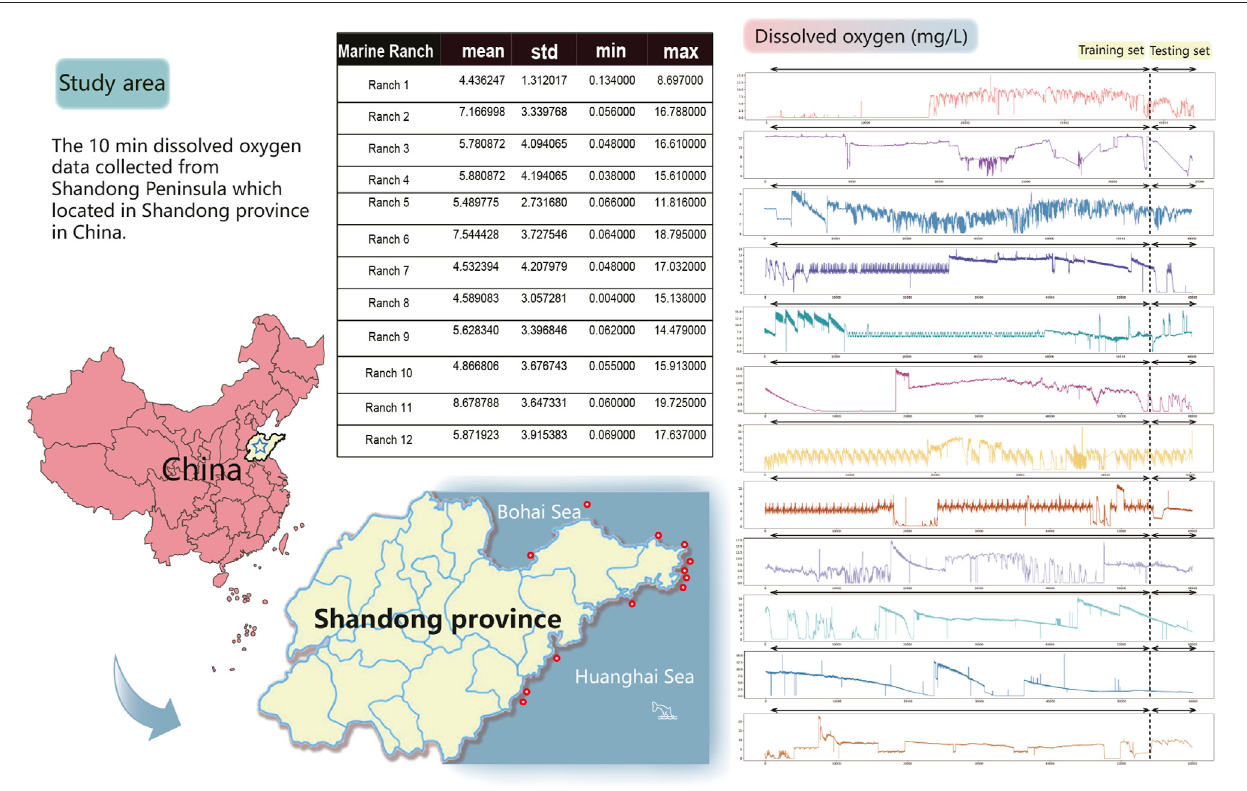
FIGURE 1 | Research information of the original